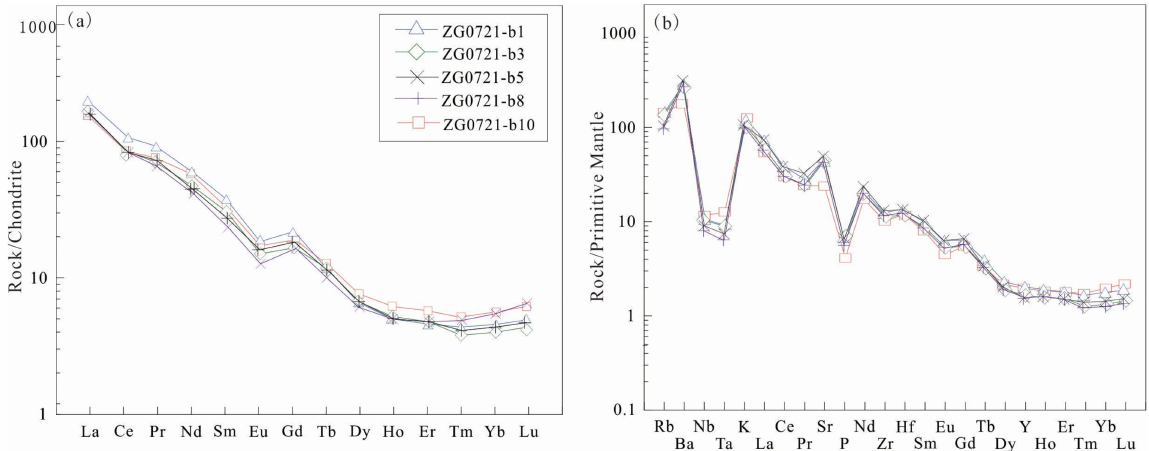
Figure 4. Chondrite-normalized rare earth elements diagram ( a ) and primitive mantle-normalized spider diagram for trace elements ( b ) of the Zhouguan granodiorite (the normalized values according to Sun and McDonough, 1989